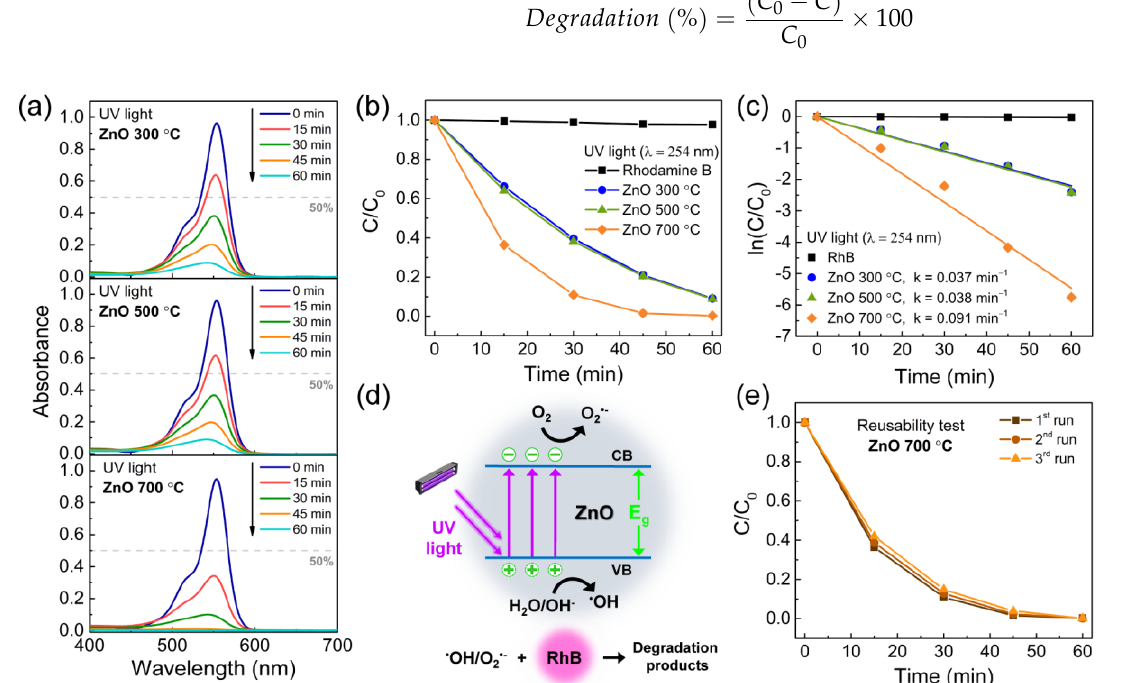
Figure 4. ( a ) Absorbance spectra of RhB recorded at different degradation times under UV irradiation for ZnO samples calcinated at 300, 500, and 700 °C. ( b ) Degradation ratio C/C 0 of RhB vs. UV exposure time for all the produced porous ZnO samples. ( c ) ln( C/C 0 ) vs. UV exposure time and the resultant degradation rates k for each tested sample. ( d ) UV light photocatalytic mechanism of ZnO. ( e ) Reusability tests of the ZnO sample calcinated at 700 °C showing the degradation ratio C/C 0 for three photocatalytic runs.